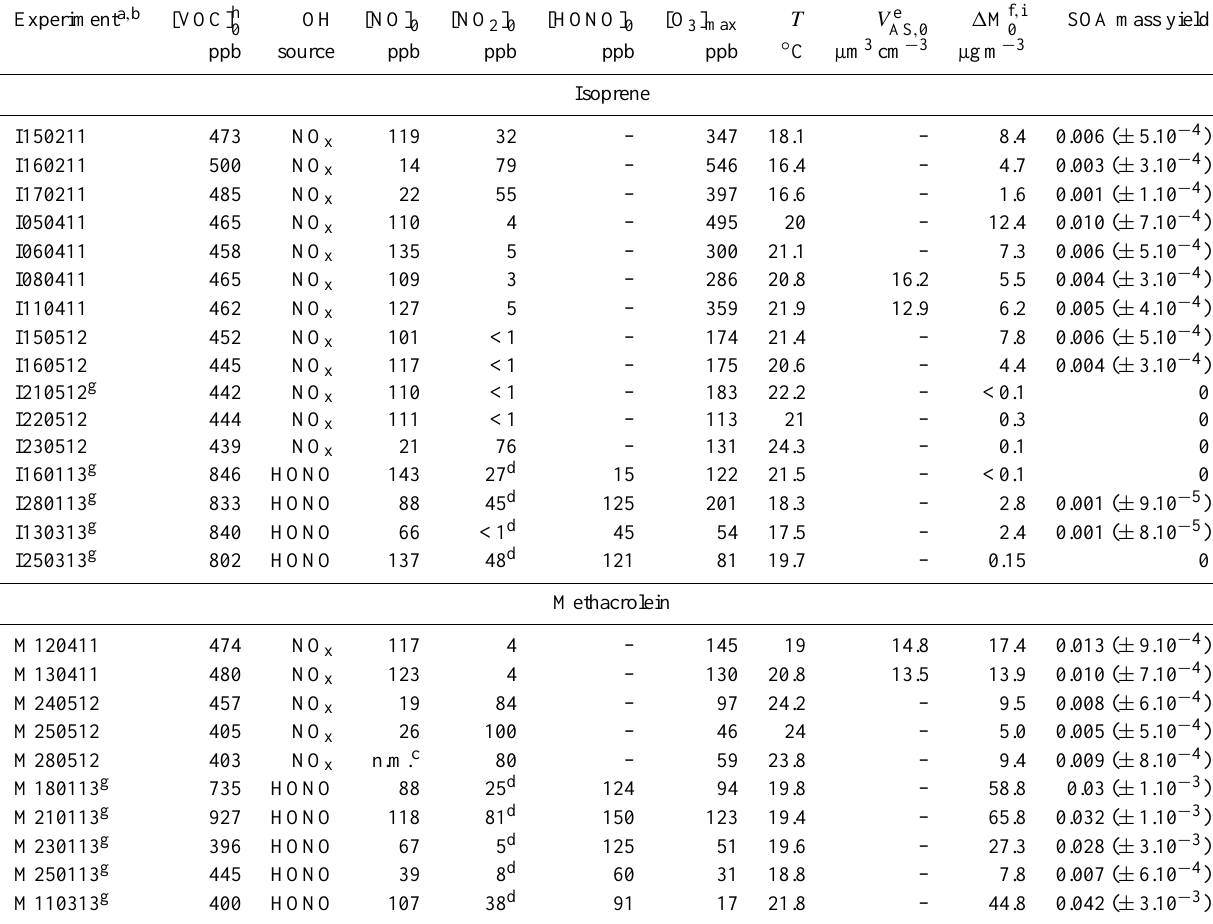
Table 1. Experimental conditions and results. Experiment a ,